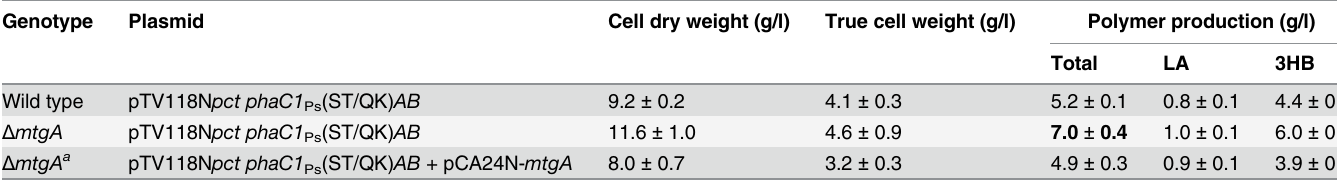
Table 2. P(LA- co -3HB) production in mtgA -deleted and complemented strains. Genotype Plasmid